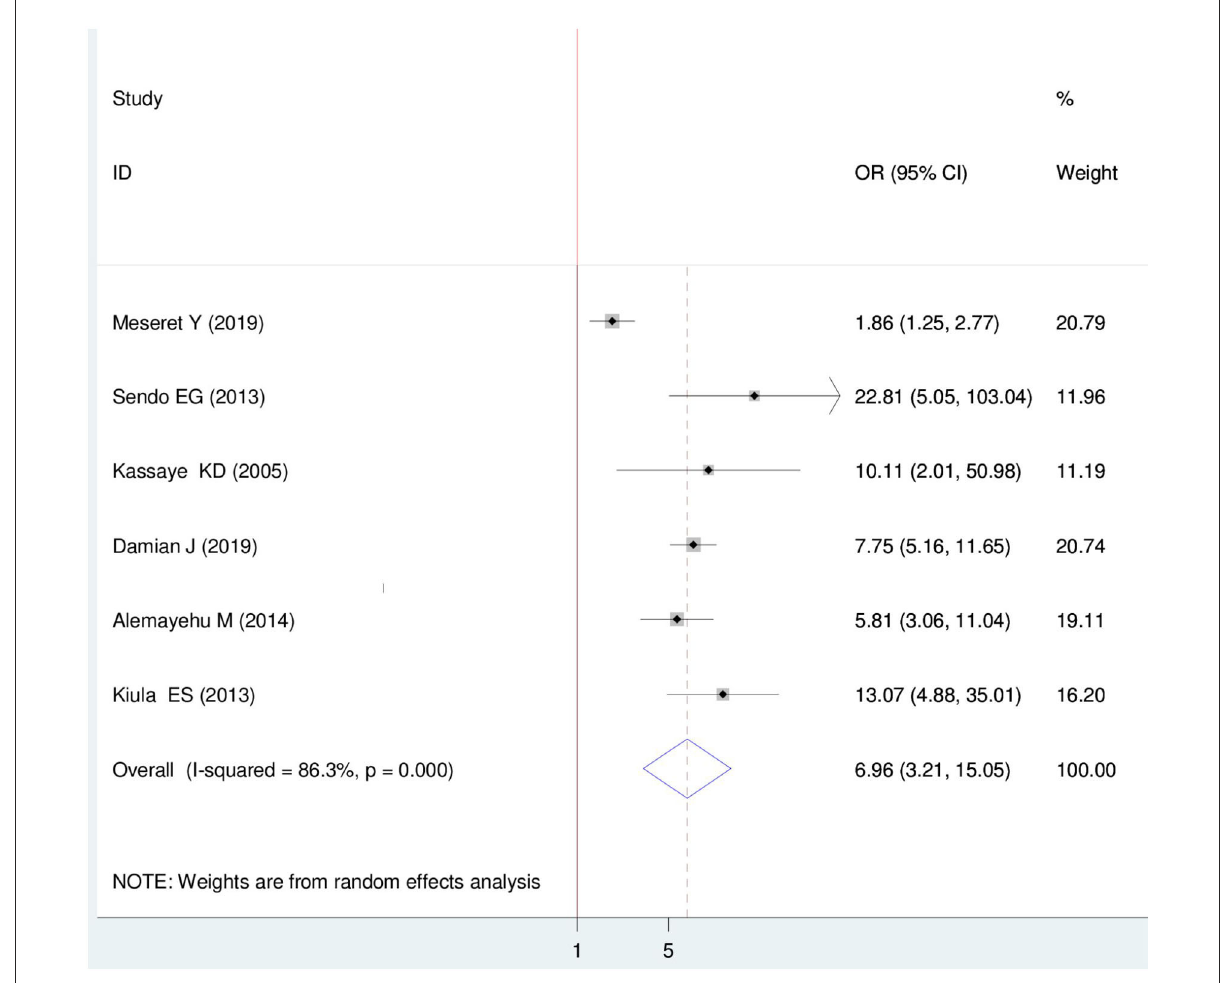
FIGURE9 Forest plot of association between HIV sero-status disclosure and discussion on HIV before test among women in East Africa,